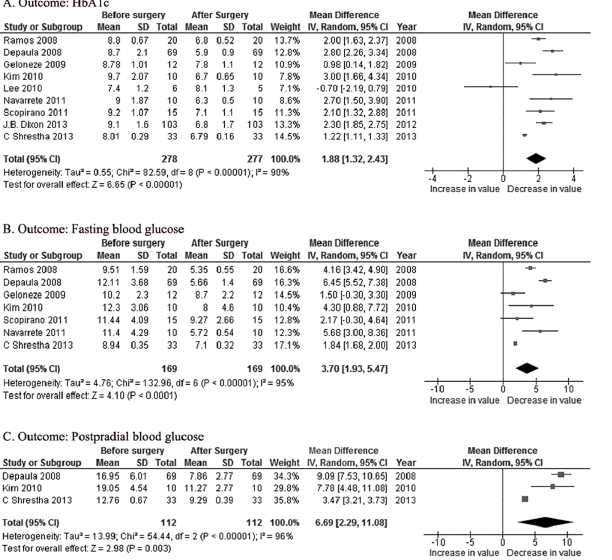
Fig 3. Forest plotsof the effects of metabolic surgery on: (A) HbA1c; (B) fasting blood glucose; and (C) postpradial blood glucose. CI = confidence interval; IV = inverse variance; SD = standard deviation.